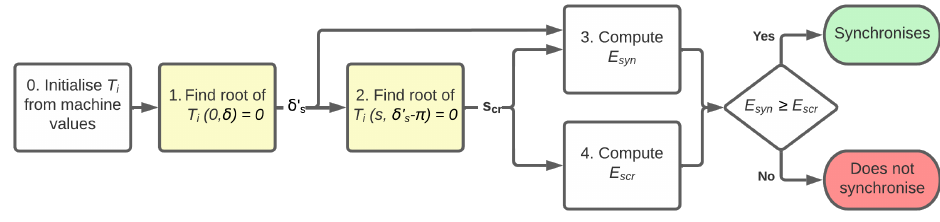
Figure 15. Flowchart implementing the energy method (Rabbi et al.).